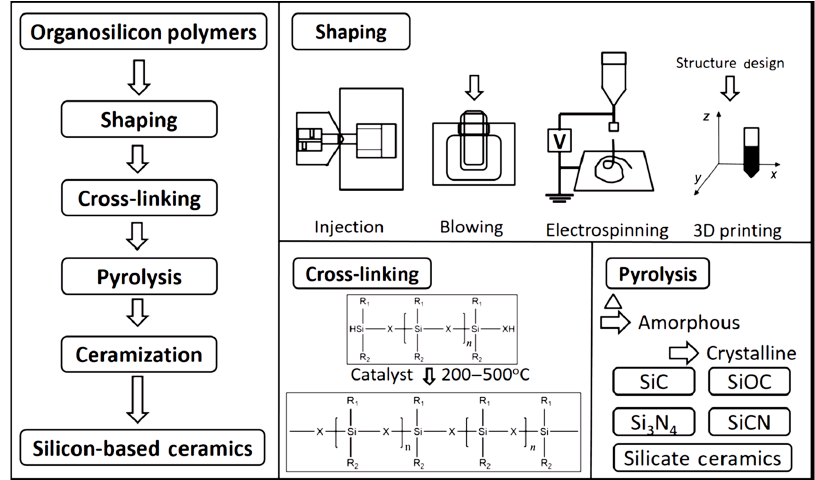
Figure 1. Preparation of ceramic products by PDCs technology [50].